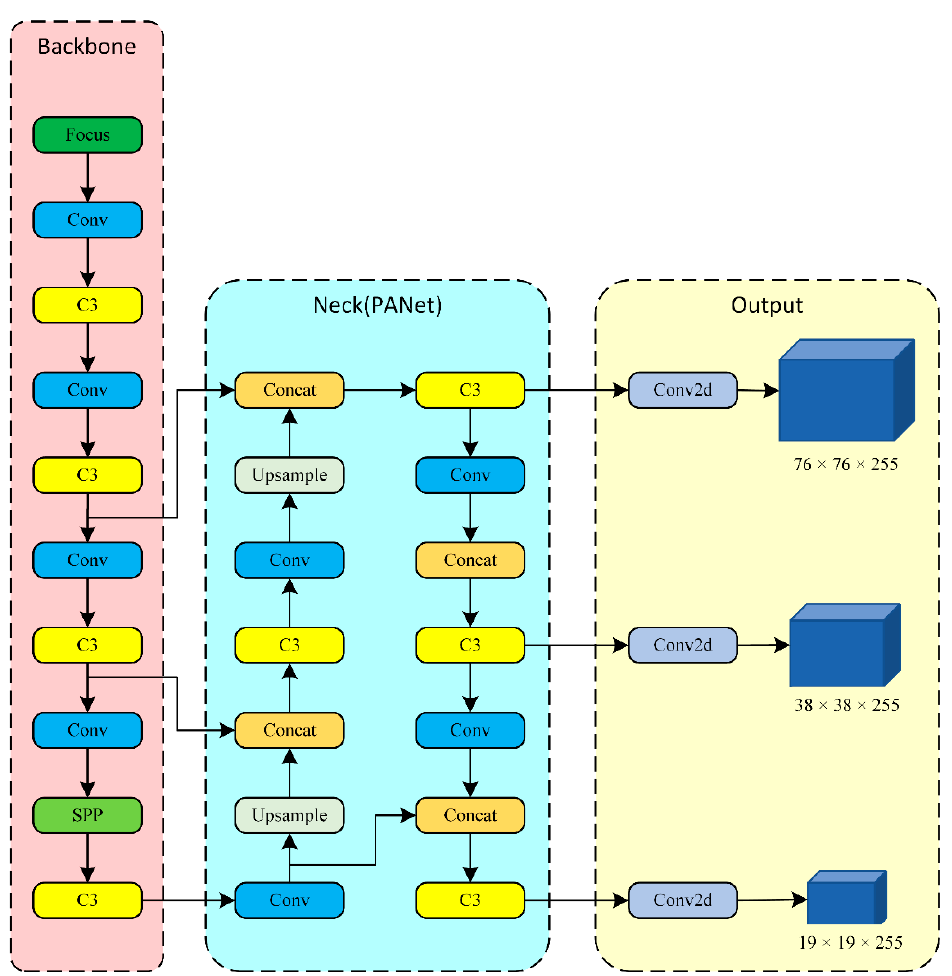
Figure 1. YOLOv5 network structure.